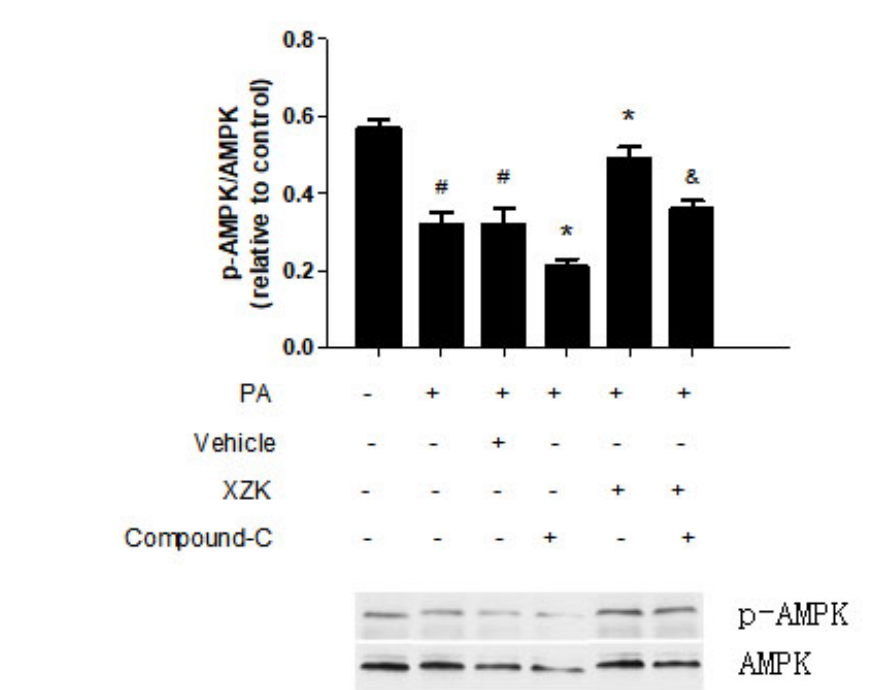
FIGURE 5 - The p-AMPK and AMPK protein expressions in HepG2 cells after signaling pathway inhibitor intervention detected by Western blot. Compared with the un-treated group,#P<0.05; Compared with the PA-treated group,*P<0.05; Compared with the PA+XZK treated